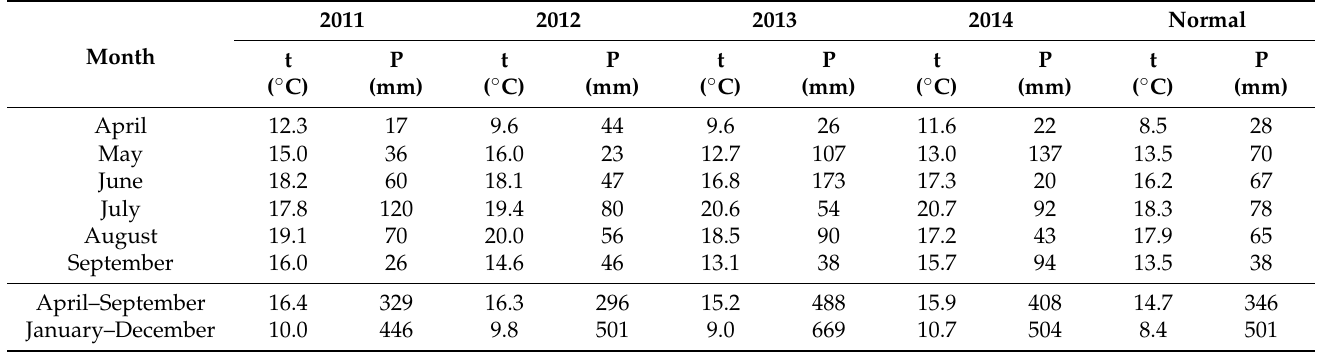
Table 1. Monthly mean air temperature (t) and monthly sums of precipitation (P) in 2011–2014 (Prague–Suchdol), and long-term climatological normal for the period 1981–2010 obtained from the meteorological station in Prague–Ruzynˇe (source: Czech Hydrometeorological Institute).